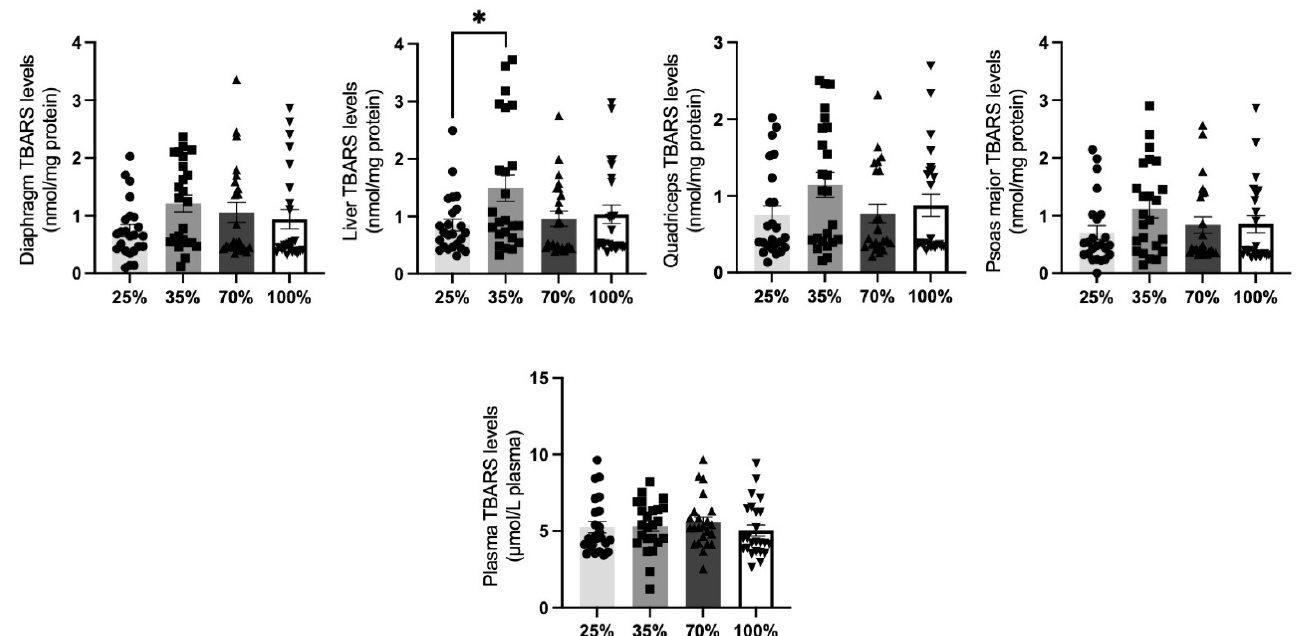
Figure 10 . TBARS levels at all 4 d.s of lambs . * denotes significant difference with p < 0.05. Figure 10. TBARS levels at all 4 d.s of lambs. * denotes significant difference with p <